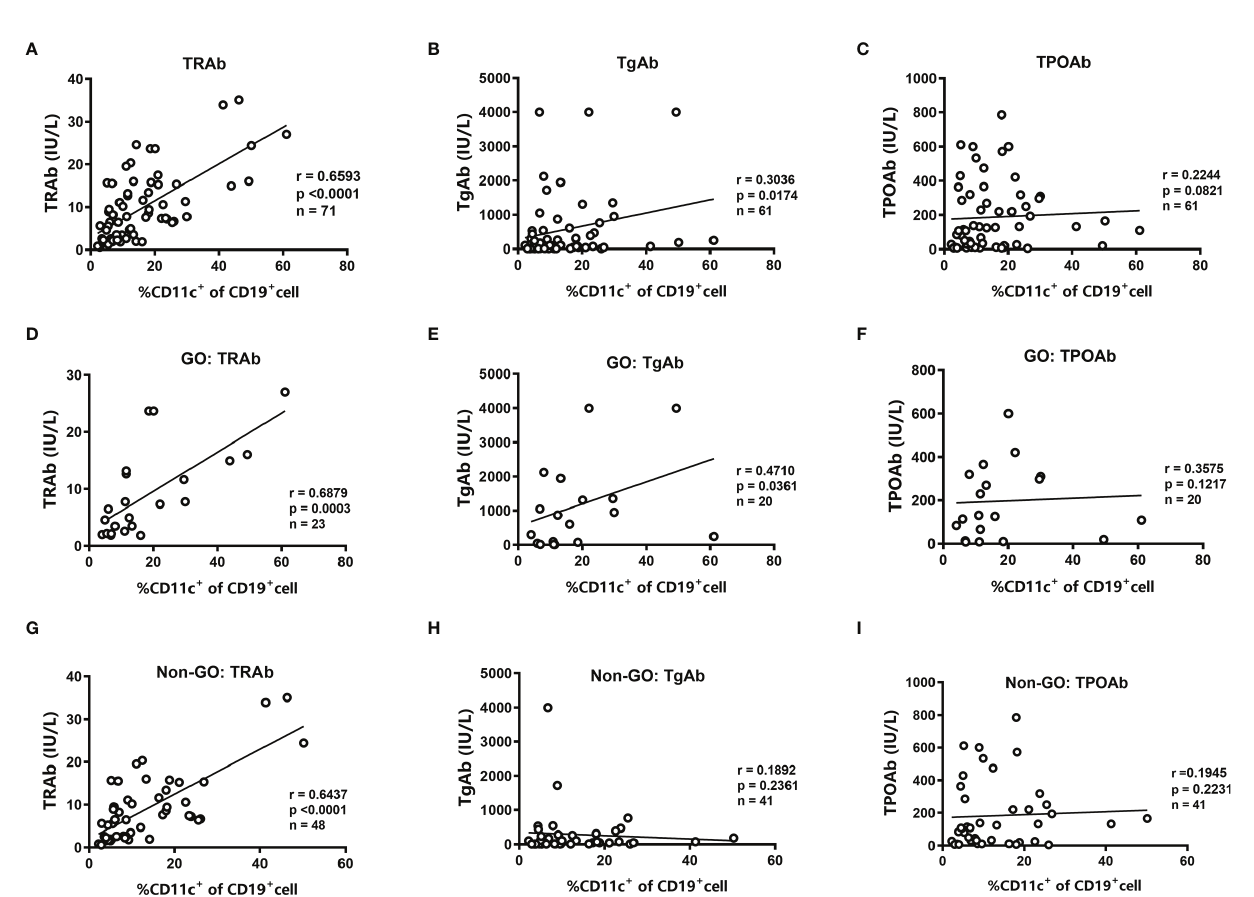
Figure 5C . The frequencies of CD38 + , CD27 + , and CD138 + cells and the MFI of CD138 were enriched in CD11c + B cells from FNA samples compared to paired CD11c - B cells ( Figures 5D, E, G ). Neither the positive cell proportion nor the MFI for IgD was found to be signi fi cantly different between paired CD11c + B cells and CD11c - B cells ( Figure 5F ). Both the positive cell frequency and MFI for T-bet were signi fi cantly increased in CD11c + B cells compared to paired CD11c - B cells ( Figure 5H ). The phenotypic characteristics of CD11c + B cells in the FNA samples were consistent with those of CD11c + B cells in the PB, which indicated that these cell populations might have the same origin.